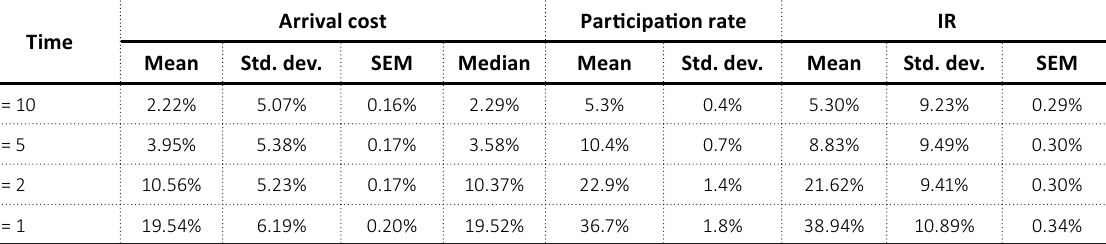
Table 2. Descriptive statistics for various frequencies (participation rates) of metaorder execution Time